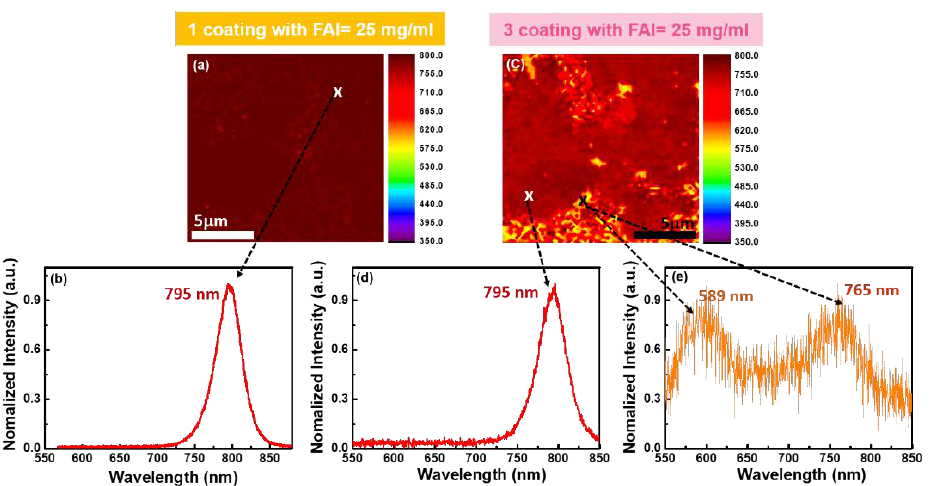
Figure 4. ( a ) PL mapping and ( b ) PL spectra of α -FAMAPbI 3 with 1 coating of FAI = 25 mg/mL; ( c ) PL mapping of 3 coatings of FAI = 25 mg/mL; corresponding nonuniform PL spectra of ( d ) α -FAMAPbI 3 and ( e ) showing δ -FAPbI 3 and FA-rich α -FAMAPbI 3 .